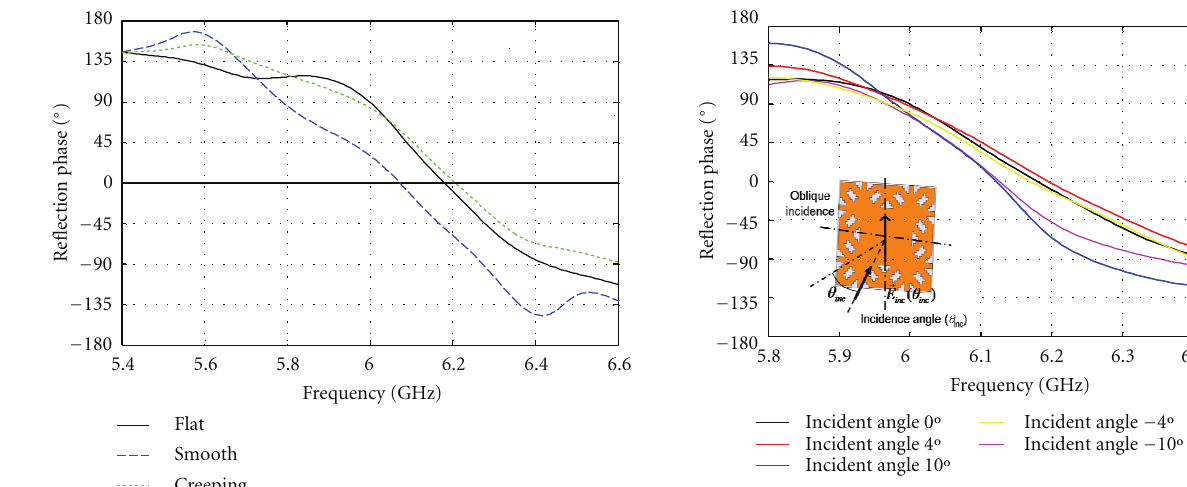
Figure 6: Measured reflection coe ffi cient phase of the flat and bent prototypes versus frequency.